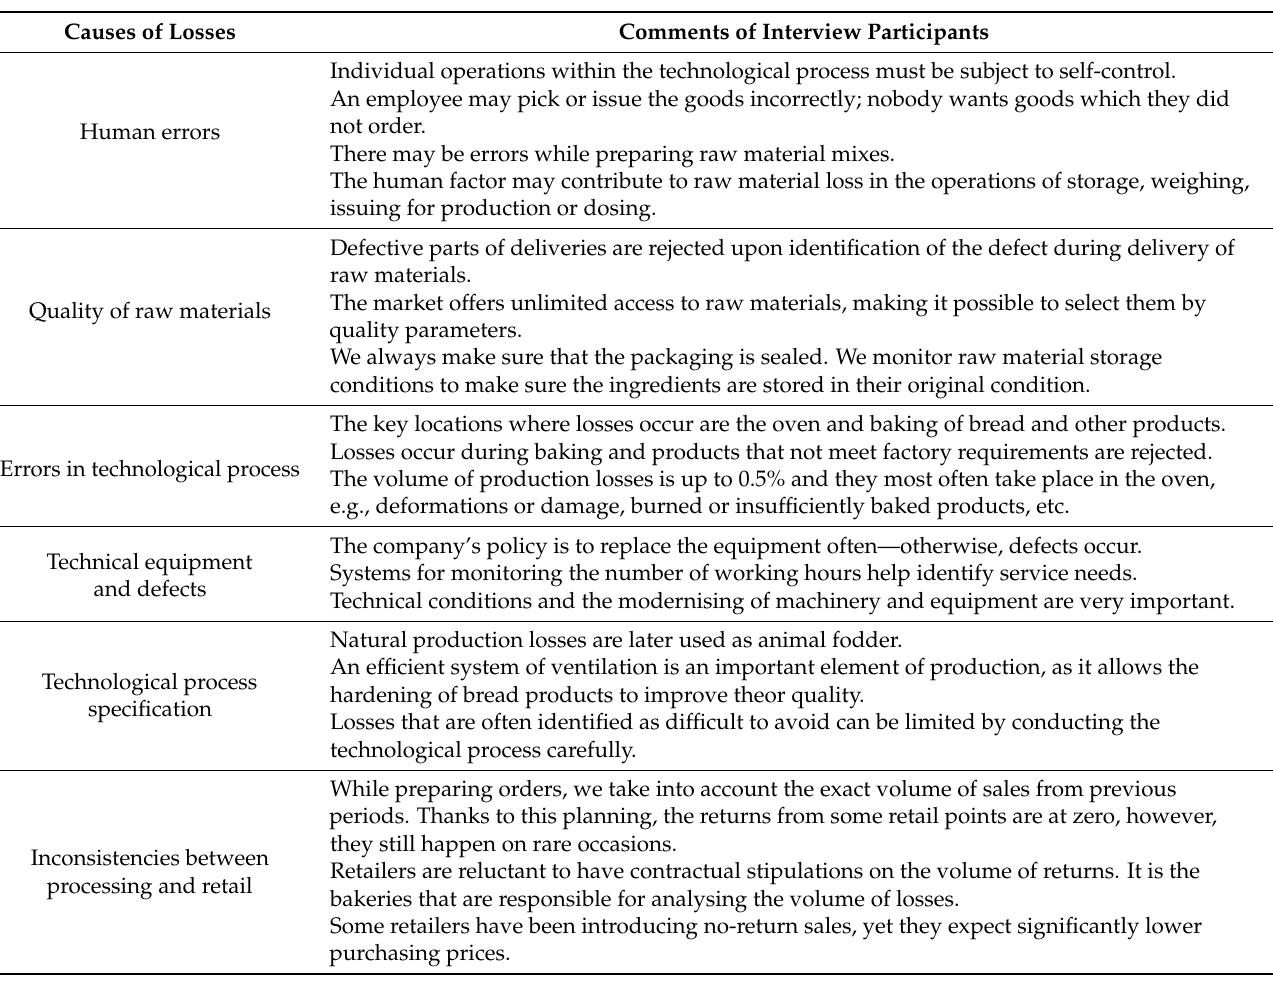
Table 5. Selected comments of interview participants concerning the causes of